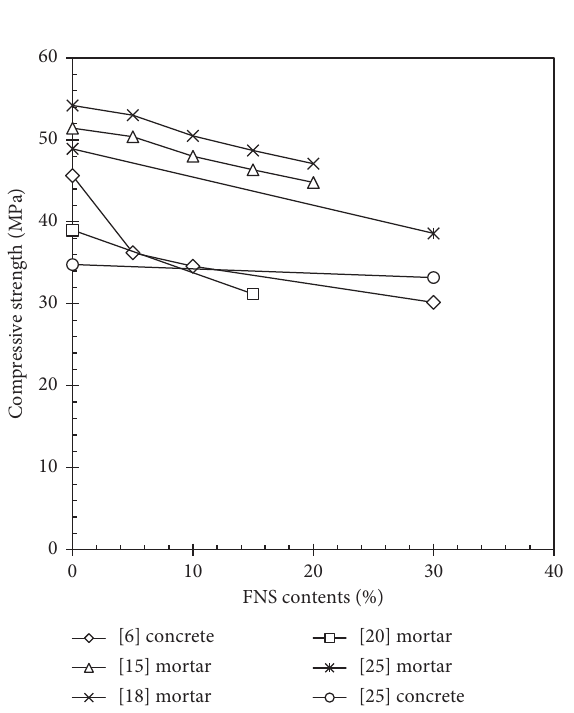
Figure 3: Compressive strength at 28 days of curing ages.